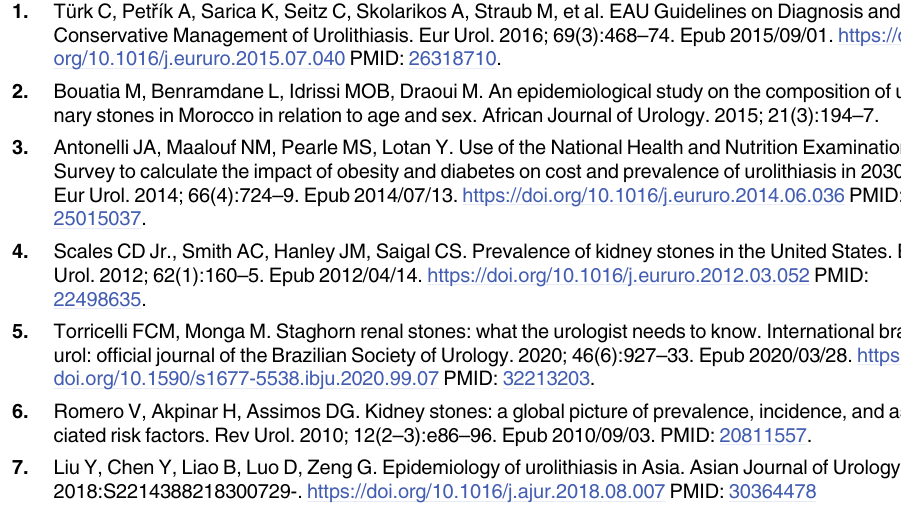
S1 Checklist. Effect of dietary treatment and fluid intake on the prevention of recurrent calcium stones and changes in urine composition: A meta-analysis and systematic review. S1 Table. S1 Table for quality assessment in all the selected studies for systematic review and